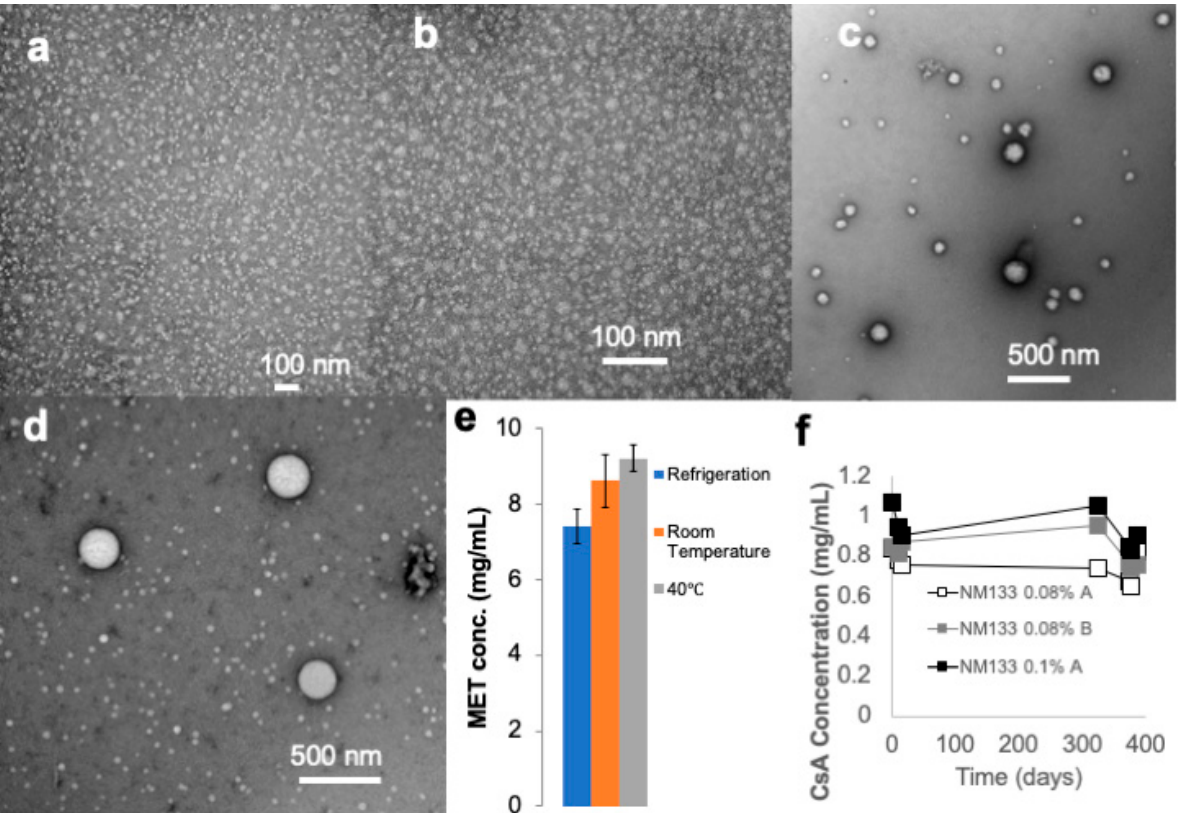
Figure 1. ( a ) Transmission electron micrograph (TEM) of freshly prepared NM133 0.05%C eye drops, ( b ) TEM of